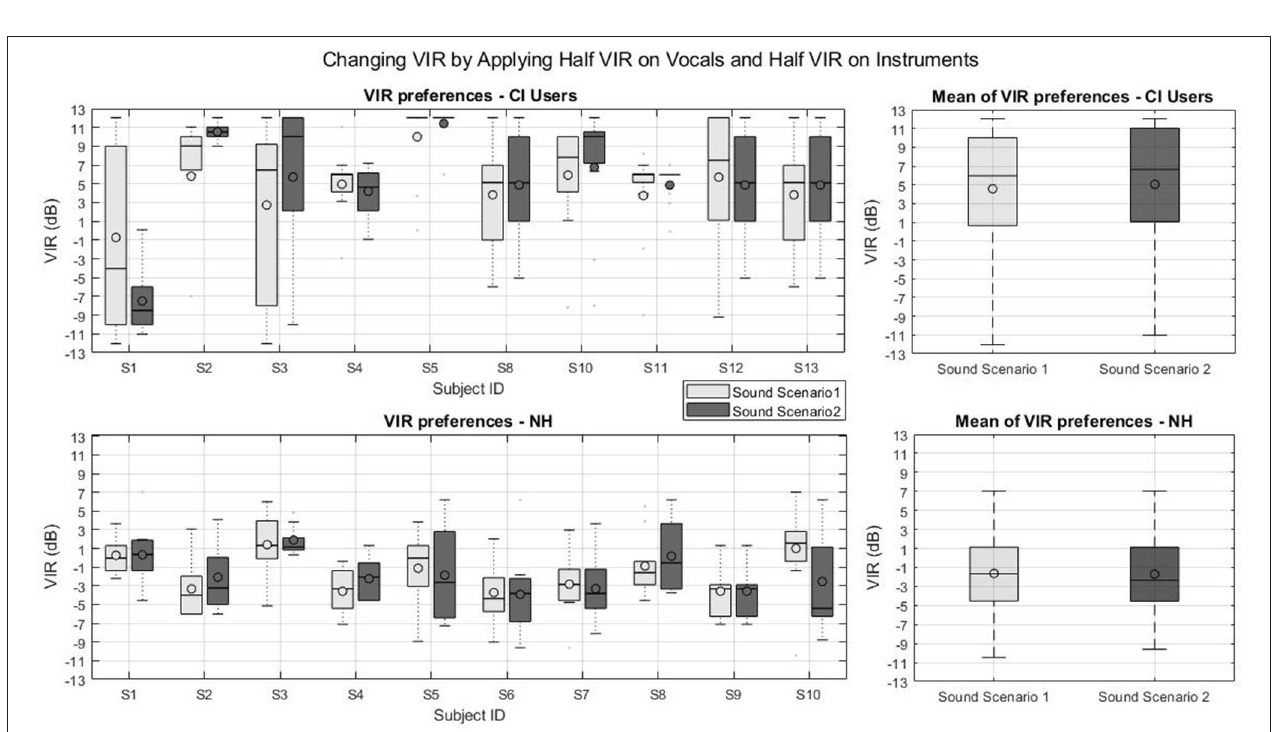
FIGURE 5 | VIR values from part two of experiment 1: Changing VIR by Applying Half VIR on Vocals and Half VIR on Instruments. (Top left) VIR preferences of CI users, (Top right) mean VIR of CI users, (Bottom left) VIR preferences of NH subjects, (Bottom right) mean VIR of NH subjects.